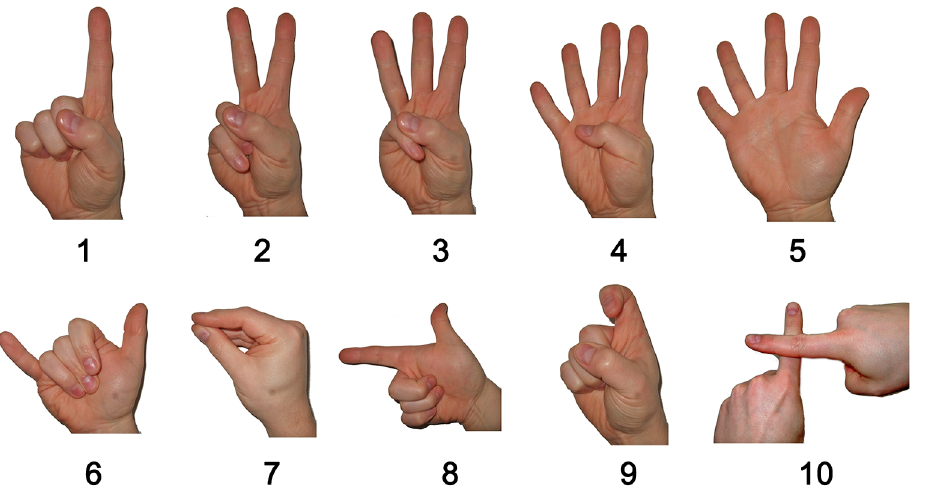
Figure 1. Chinese finger-counting